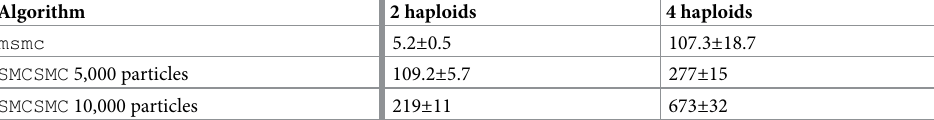
Table 1. Runtimes (total CPU time, hours) for analyzing one or two diploid human genomes using msmc (40 EM iterations), and SMCSMC (15 Variational Bayes iterations). Table lists means ± one standard deviation across 10 independent runs in a high performance compute environment. Note that due to parallel execution of SMCSMC (146 genomic chunks) and msmc (8 cores), wall clock time was considerably less than the total CPU